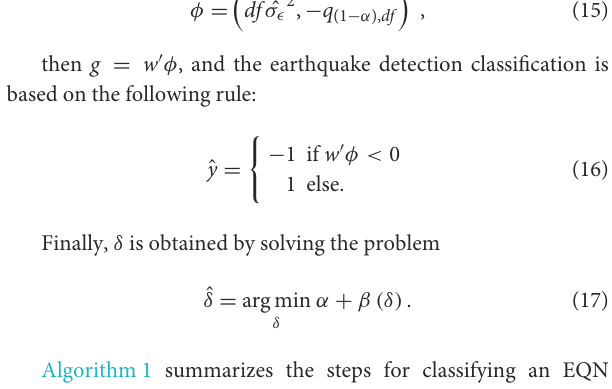
Algorithm 1 summarizes the steps for classifying an